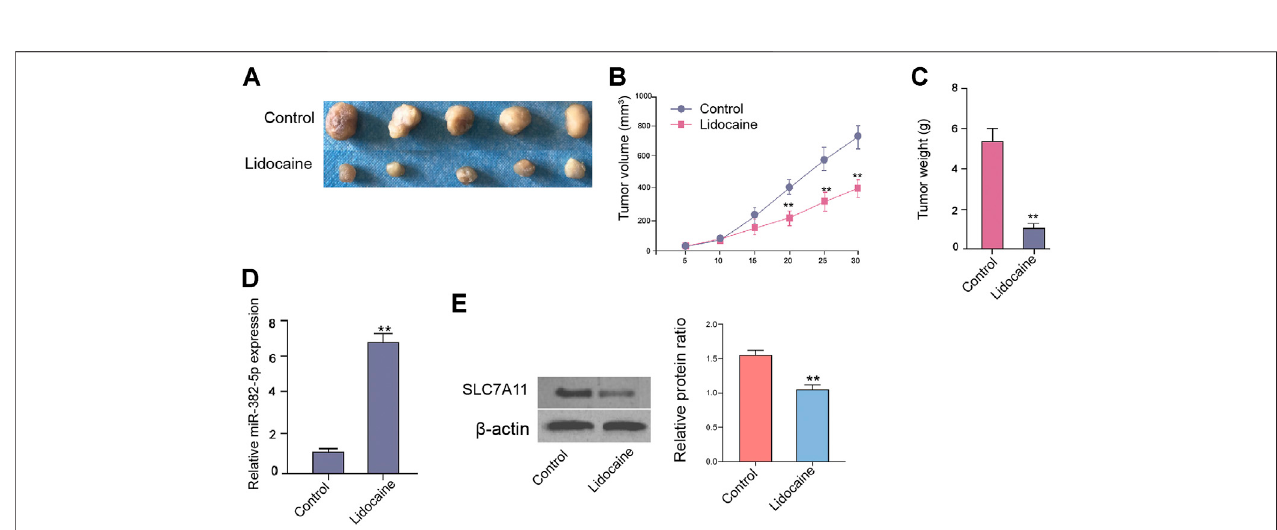
FIGURE7| Lidocaineattenuatesproliferationofovariancancercells invivo .ThenudemicewereinjectedwithSKOV-3cellsandtreatedwithlidocaine(1.5 mg/kg). The tumor tissues (A) , tumor volume (B) , and tumor weight (C) were shown. (D) The expression of miR-382-5p was analyzed by qPCR assays. (E) The protein expression of SLC7A11 was detected by Western blot analysis. The results were quanti fi ed using ImageJ software. N (cid:2) 5, mean ± SD, ** p < 0.01.